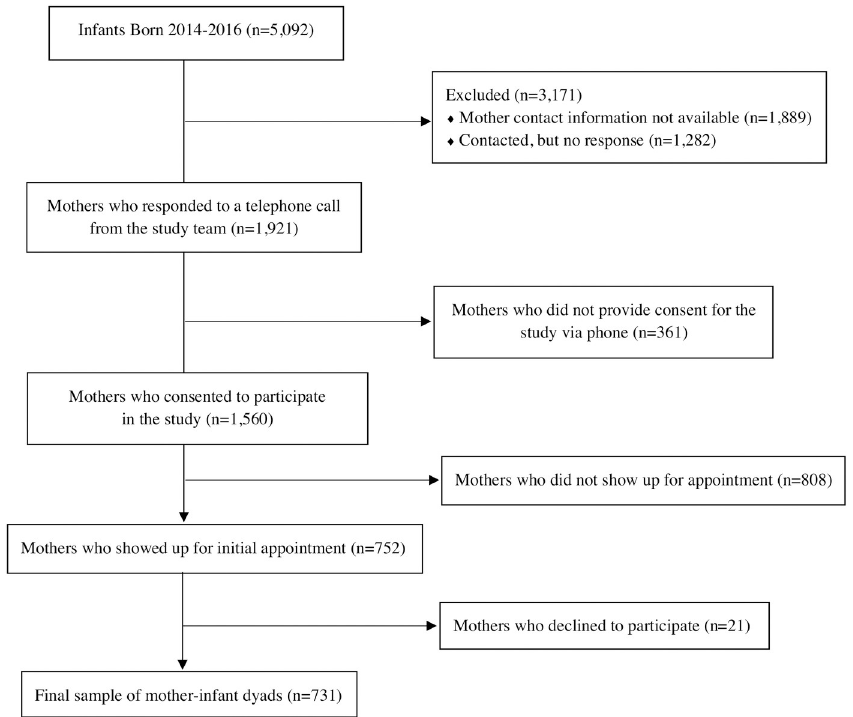
Fig 1. Flow chart of participation recruitment.